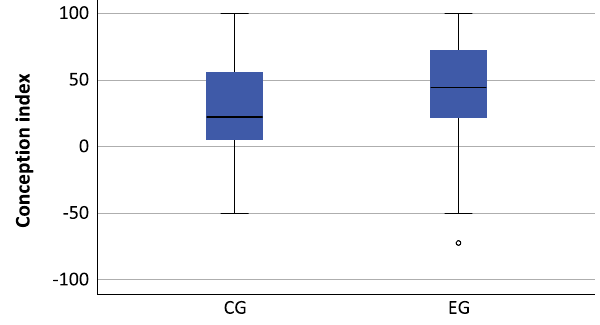
7. Distribution of the post-test values of the conception index for the scale quantum objects ’ properties and behavior in CG and EG (cf. Table